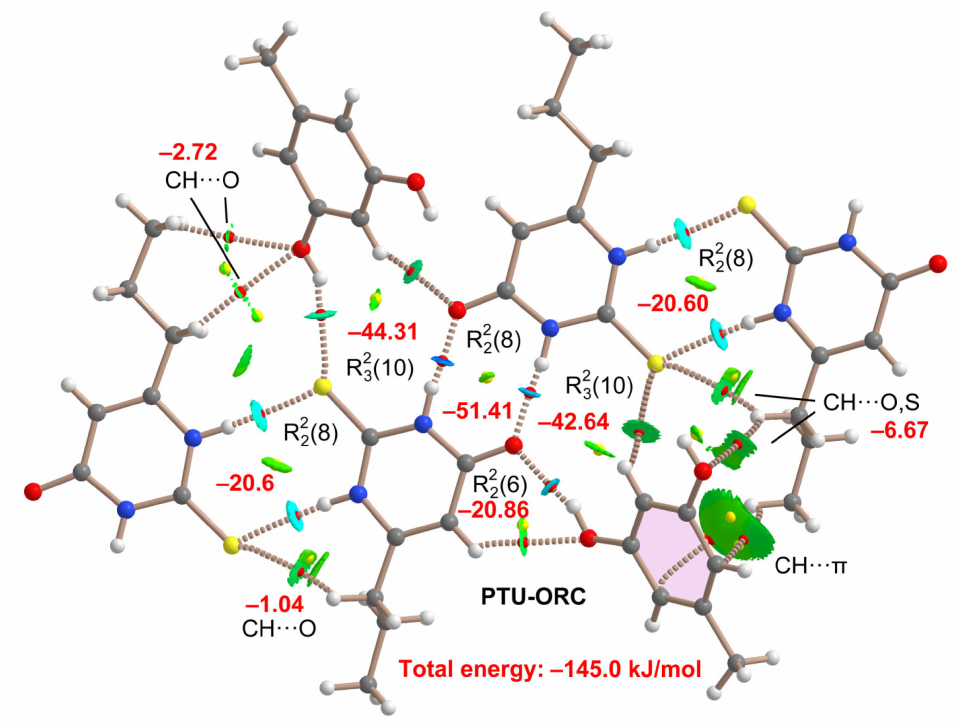
Figure 12. QTAIM/NCIPlot analysis of intermolecular bond and ring CPs (red and yellow spheres, respectively), bond paths, and RDG isosurfaces of the H-bonded assembly of PTU–ORC cocrystal. The individual association energies of each synthon or CH ··· O H-bond are indicated using a red font inside the supramolecular rings or adjacent to the CH ··· O H-bonds.